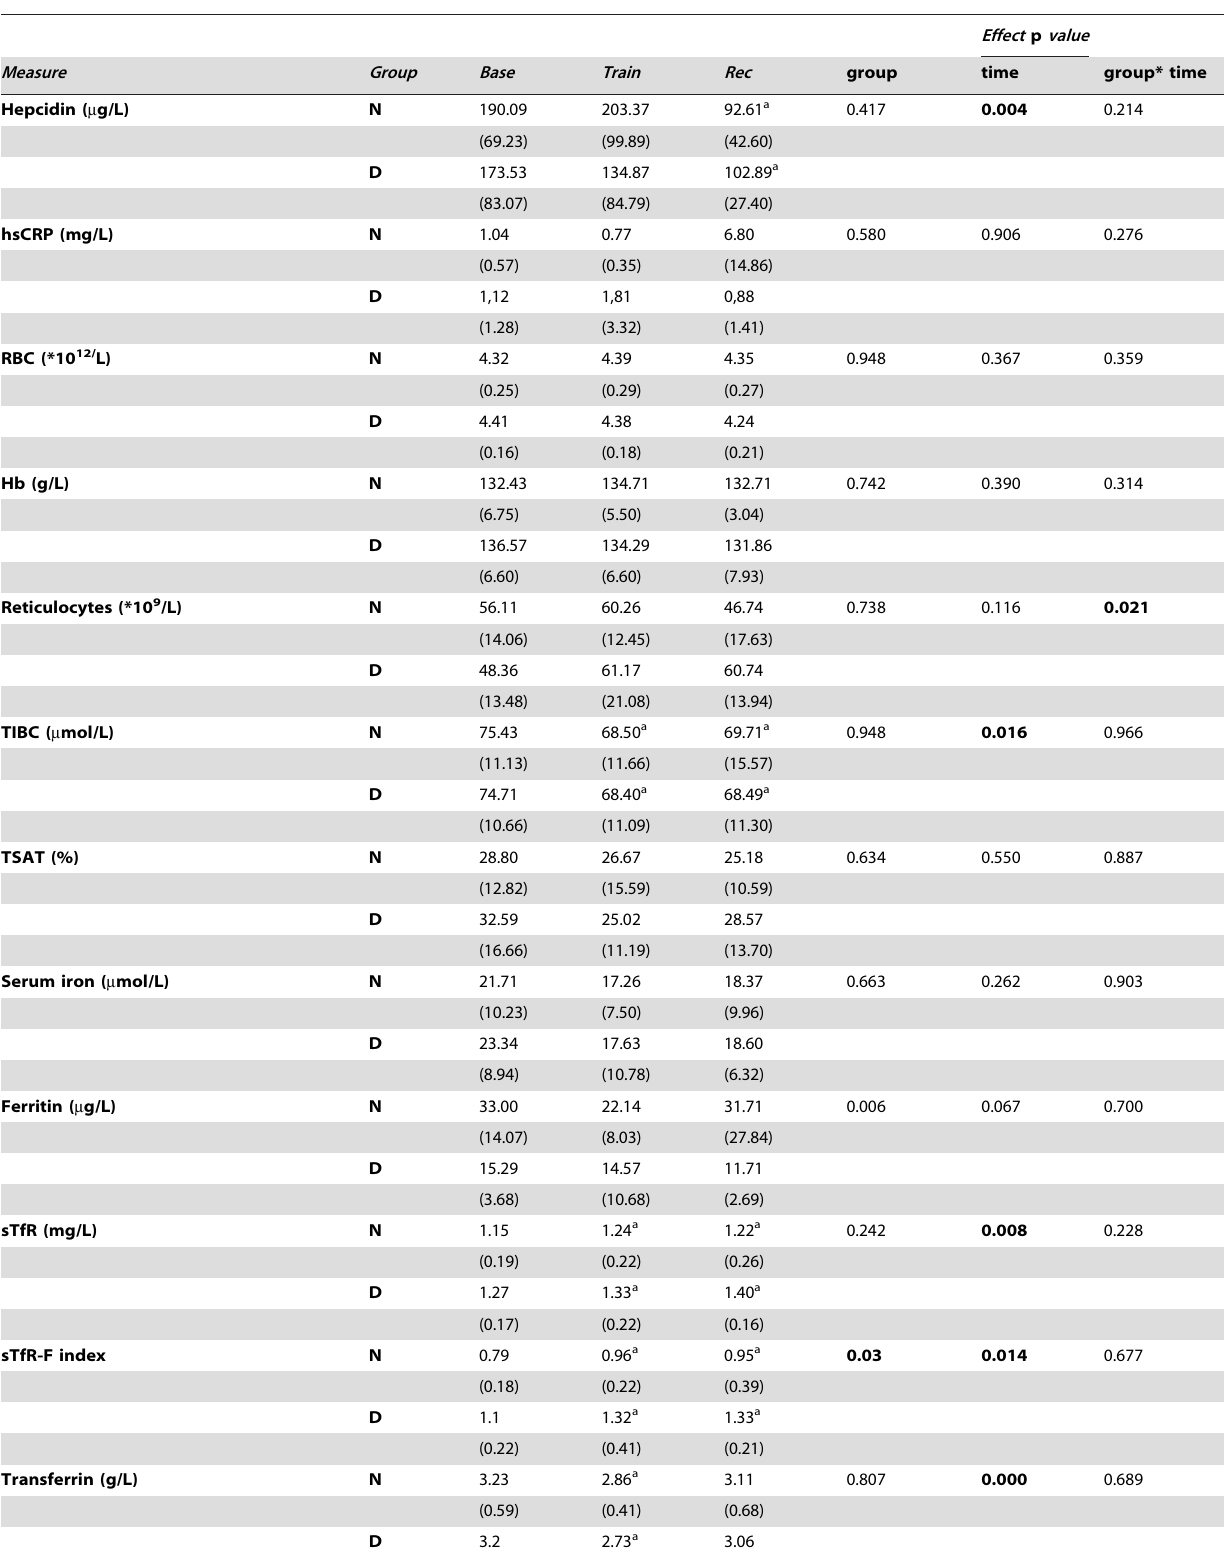
Table 2. Mean values ( 6 SD) of selected laboratory parameters measured at baseline, after eight weeks endurance training and after the recovery process in relation to baseline iron